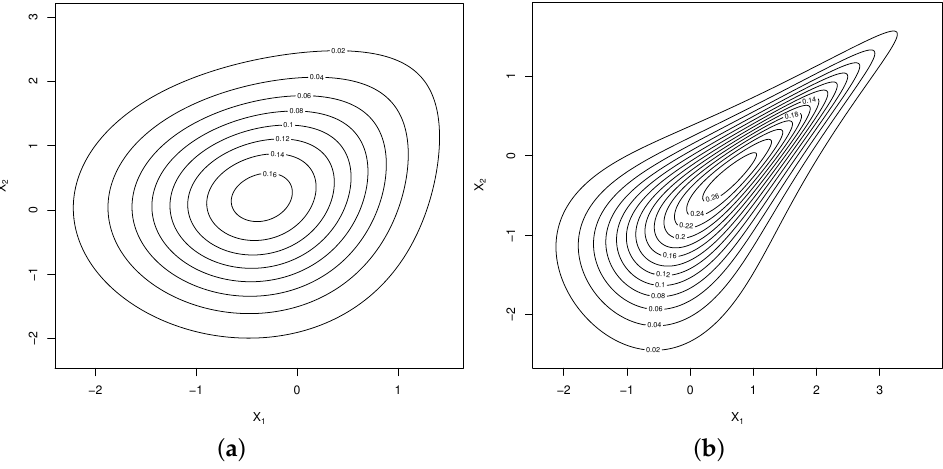
Figure 2. Contour plots: ( a ) BPHN(0,1,1.5,0,1,0.75,3.5), and ( b )